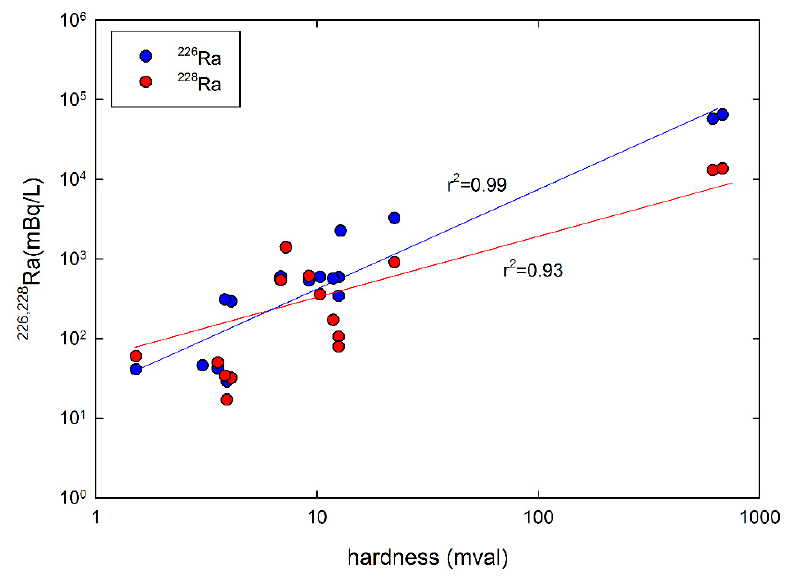
Figure 7. Relationship between water hardness and the concentrations of radium isotopes in the studied waters.